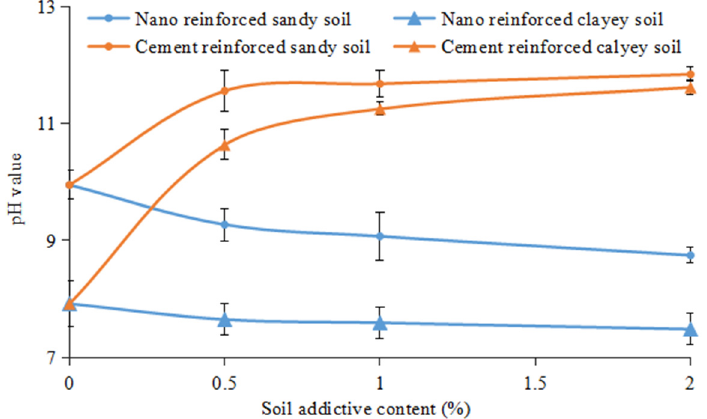
Figure 15. Effect of different additives on the pH value of clayey soil and sandy soil (values are means ± S.E.M.).